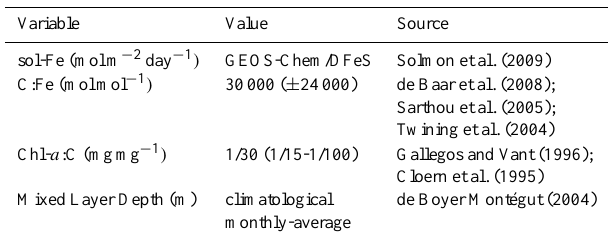
Table 1. Variables with corresponding values and (uncertainties) used in Eq.